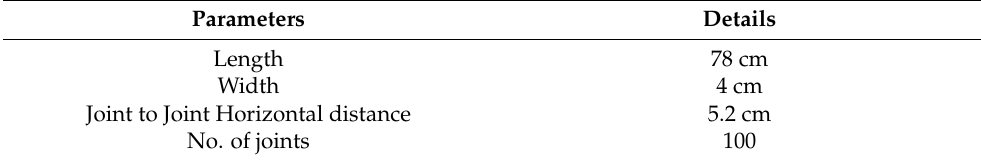
Table 4. Specifications of caterpillar